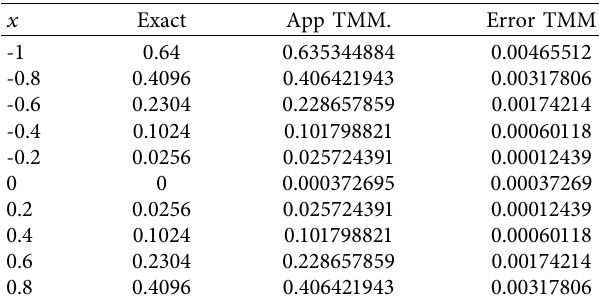
Table 5: Represents the numerical solution of (26) with generalized Logarithmic kernel and the error of TMM.